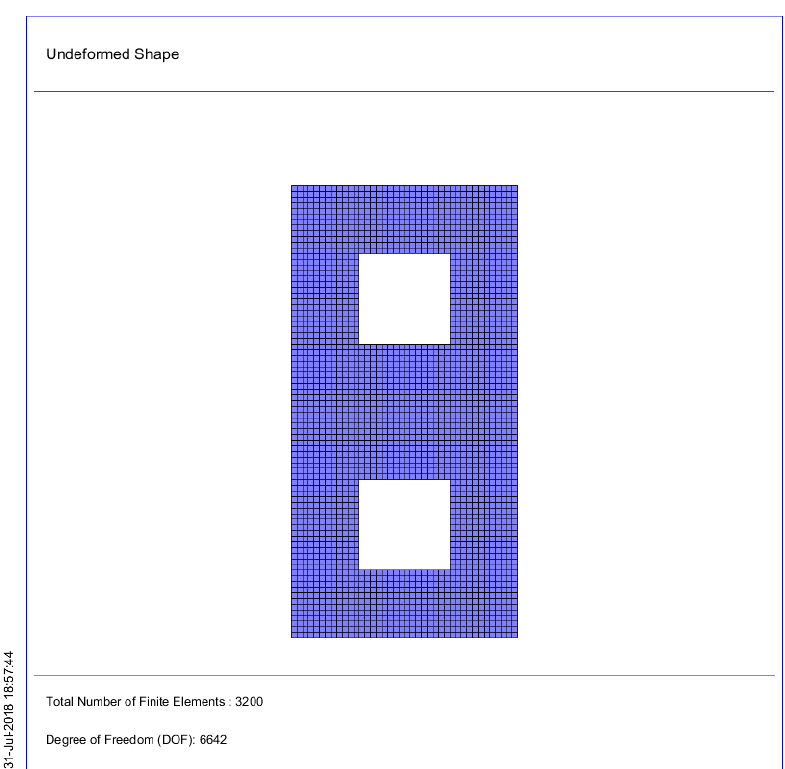
Figure 16. Undeformed shape and FE MESH of 2D masonry wall L50H100 (Figure 11a) with two openings (PGA = 0.40 g).